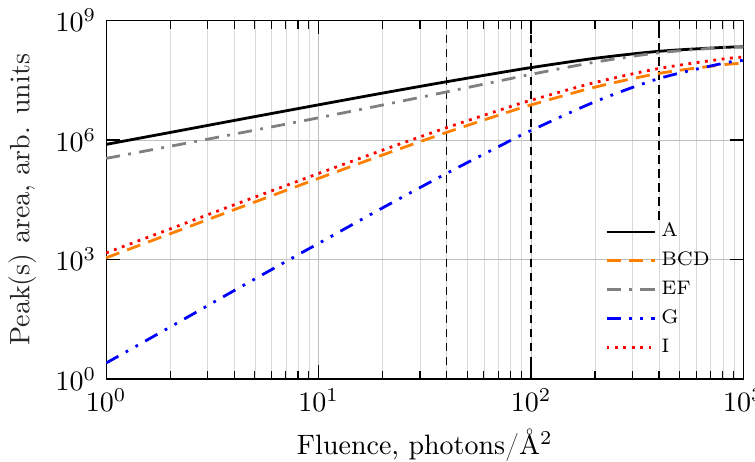
Figure 6. Intensity dependence of different photoelectron lines on the fluence F for the photon energy ω = 80 eV. Vertical dashed lines indicate fluences related to Figures 2–4: 40 ph/Å 2 , 100 ph/Å 2 , and 400 ph/Å 2